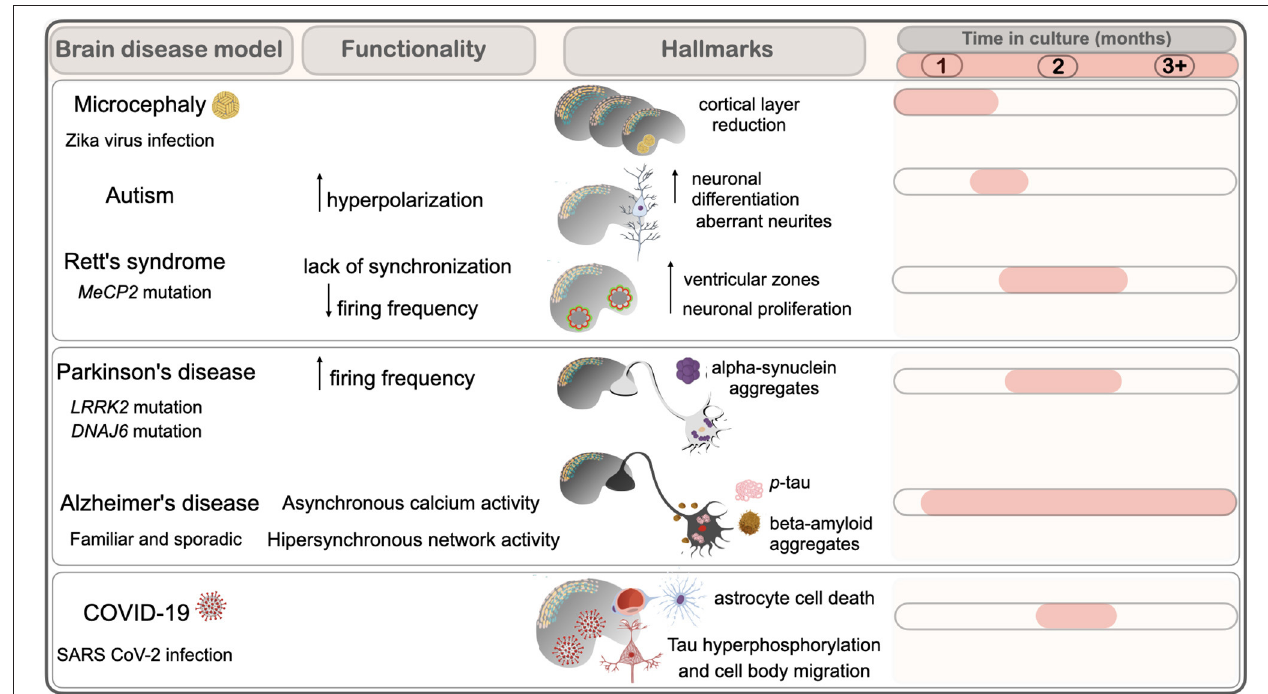
FIGURE 2 | Brain organoids models display hallmarks of neurodevelopmental and neurodegenerative diseases. Time in culture (months) of hallmarks and functional alterations observed in organoids modeling brain disorders are depicted. Neurodevelopmental disorders include microcephaly by viral infection (Zika virus), Autism and Rett’s syndrome. Neurodegenerative diseases include Parkinson’s and Alzheimer’s, and viral infection by